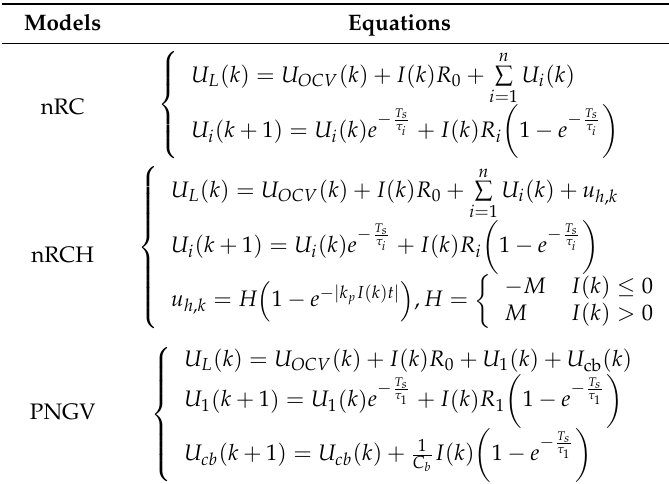
Table 2. Equations of the